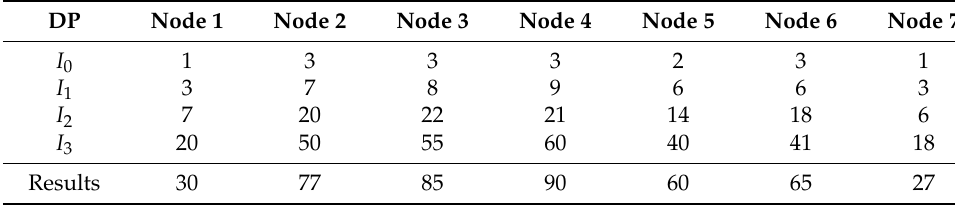
Table 1. The results of DP ( T = 3) of the example network.